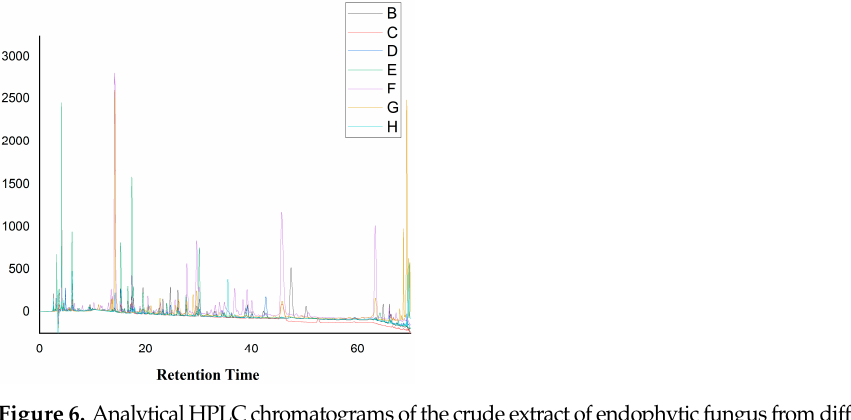
Figure 6. Analytical HPLC chromatograms of the crude extract of endophytic fungus from different medium. Recorded at 254 nm and performed using a waters column 412 and acetonitrile, 0.1% acidified water with formic acid as mobile phase. B—PBG; C—Czapeck-Dox; D—BEB; E—YPD; F—SAB; G—MEB; H—PDB.